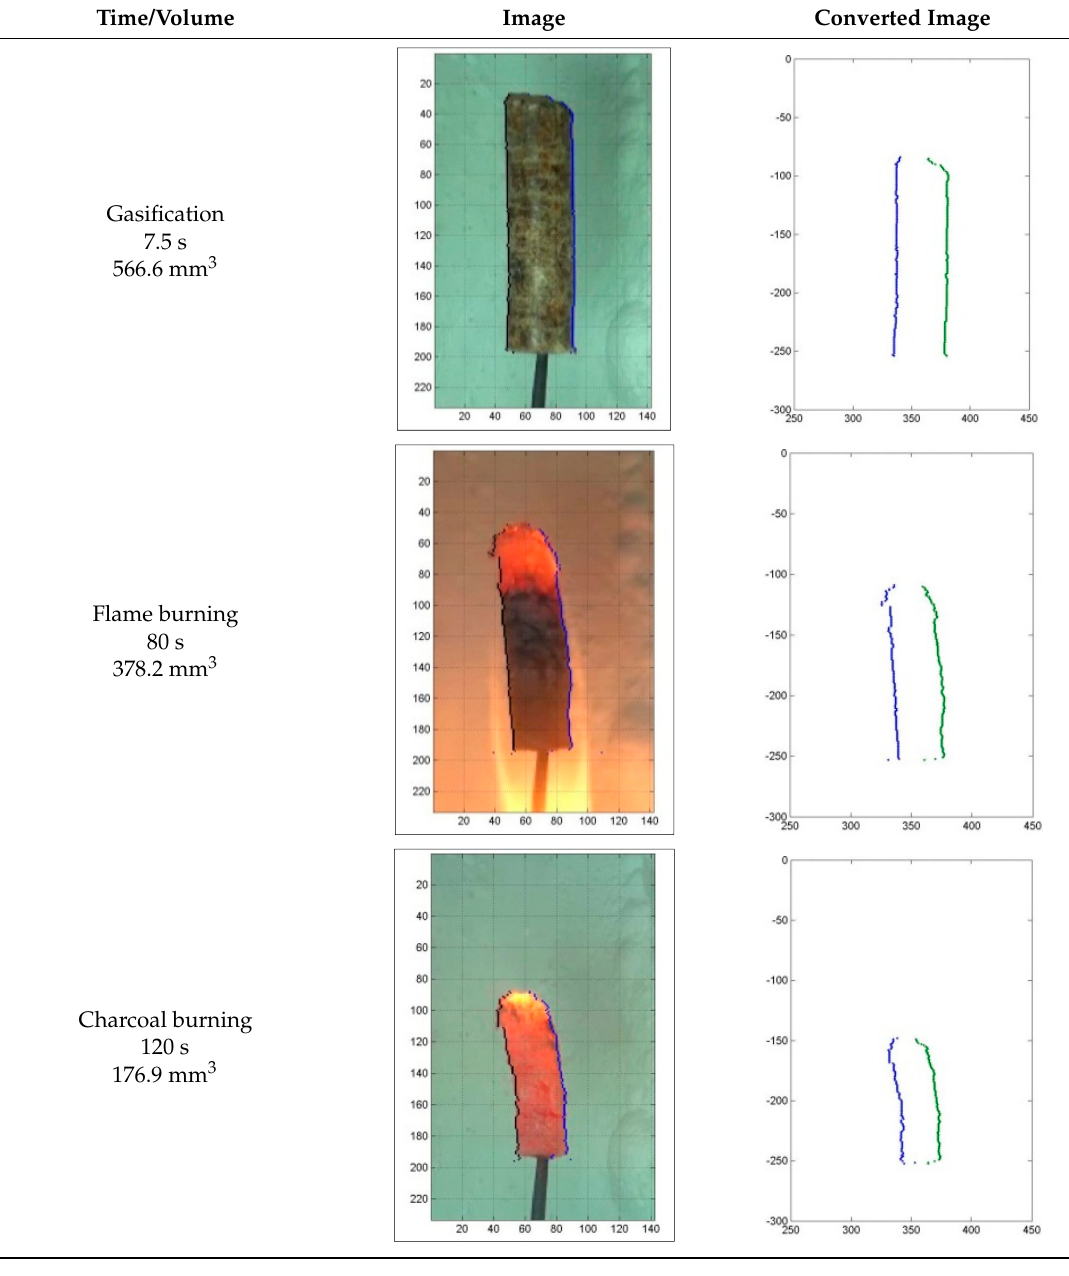
Table 3. Images of wood pellet at each combustion mode.